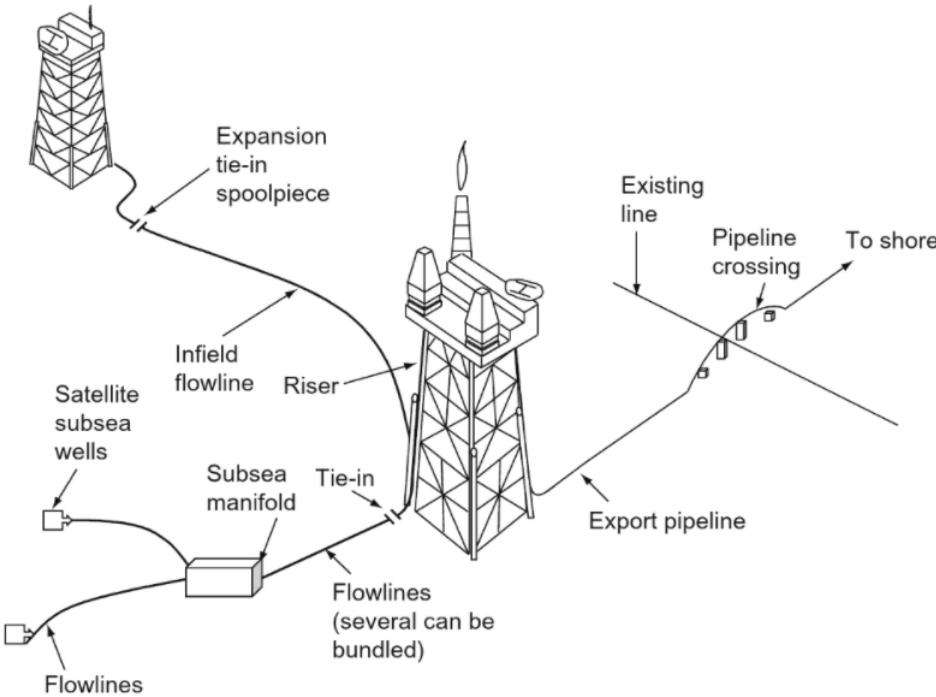
Figure 4. Uses of subsea pipelines. Reproduced from [38], with permission from Elsevier, 2022. Pipeline design is affected by multiple factors identified during the early stages (i.e.,